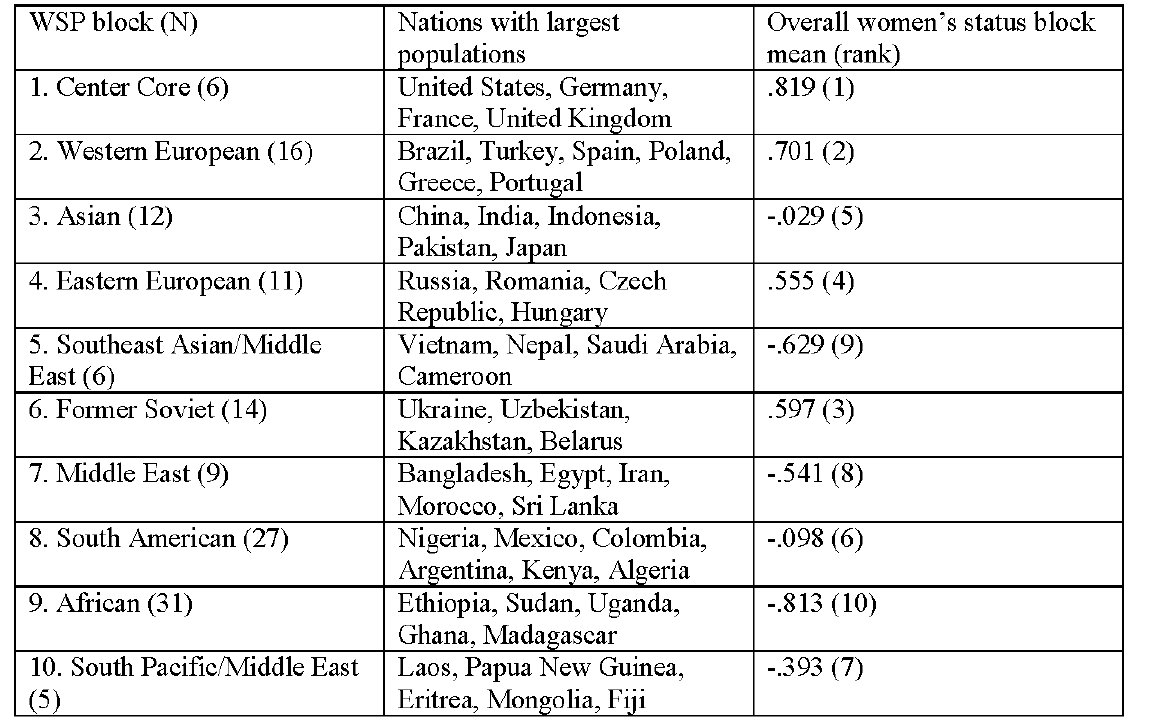
Table 2. Summary of Kick et al.'s (in press) World-System Position (WSP) Measure and Women's